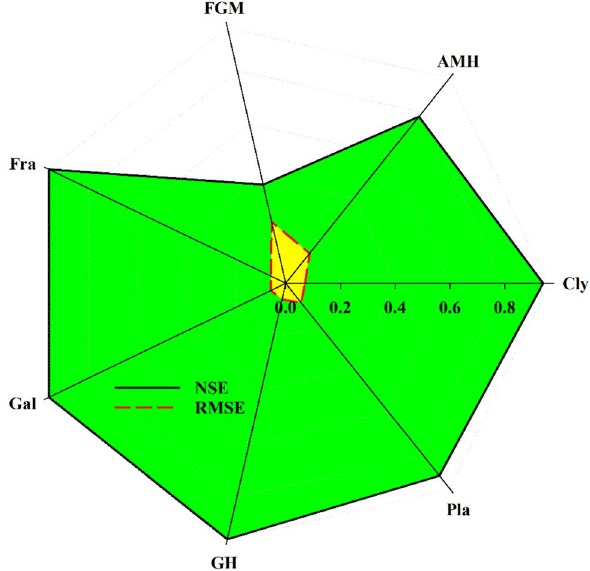
Fig. 6 NSE and RMSE evaluation statistics result for selecting the best copula with a discharge of 26.64 l/s